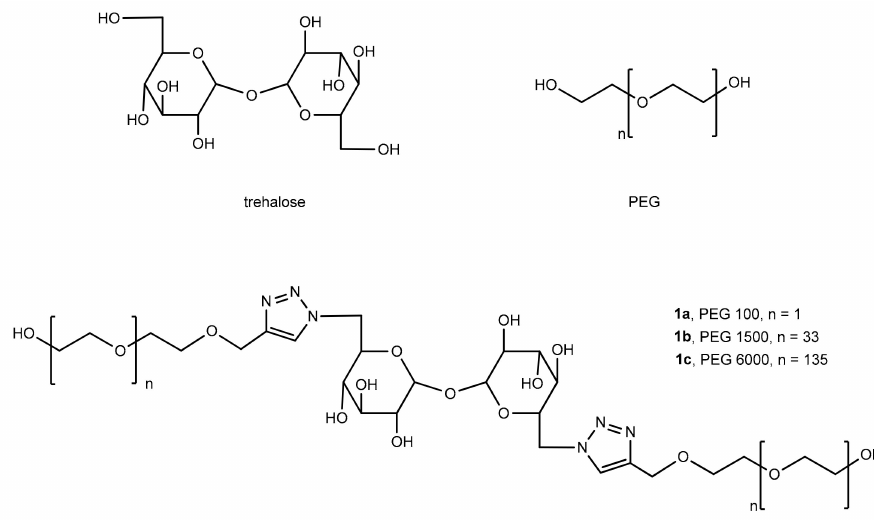
Figure 1. Chemical structures of pegylated trehalose hybrids 1a – c under